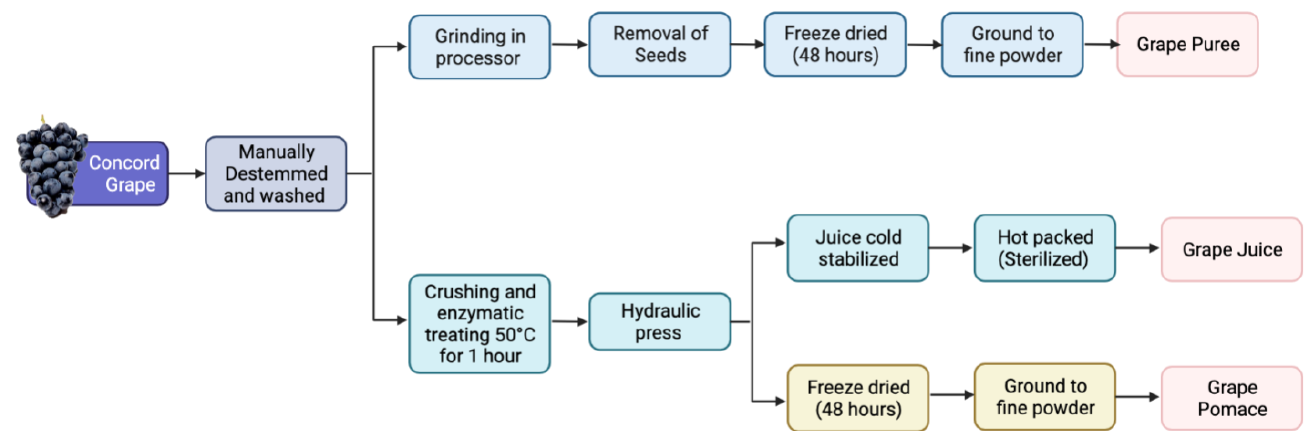
Figure 1 . depicts the processes carried out to prepare the grape puree, pomace, and juice. The Concord grapes were hand-picked, manually destemmed, and washed. The juice was cold pressed followed by sterilization. The grape puree and pomace were freeze-dried. The resultant fractions included: puree (skin + juice + flesh), juice, and pomace (skin + seeds + flesh).